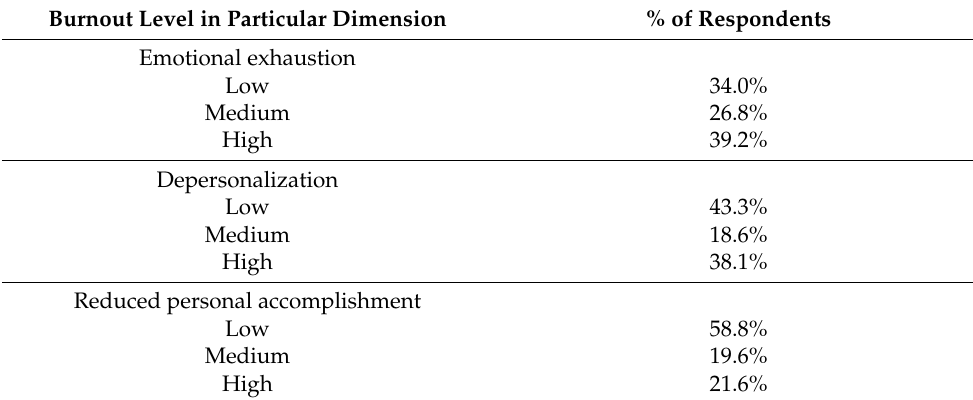
Table 3. Prevalence of high, moderate, and low levels of burnout in each dimension.